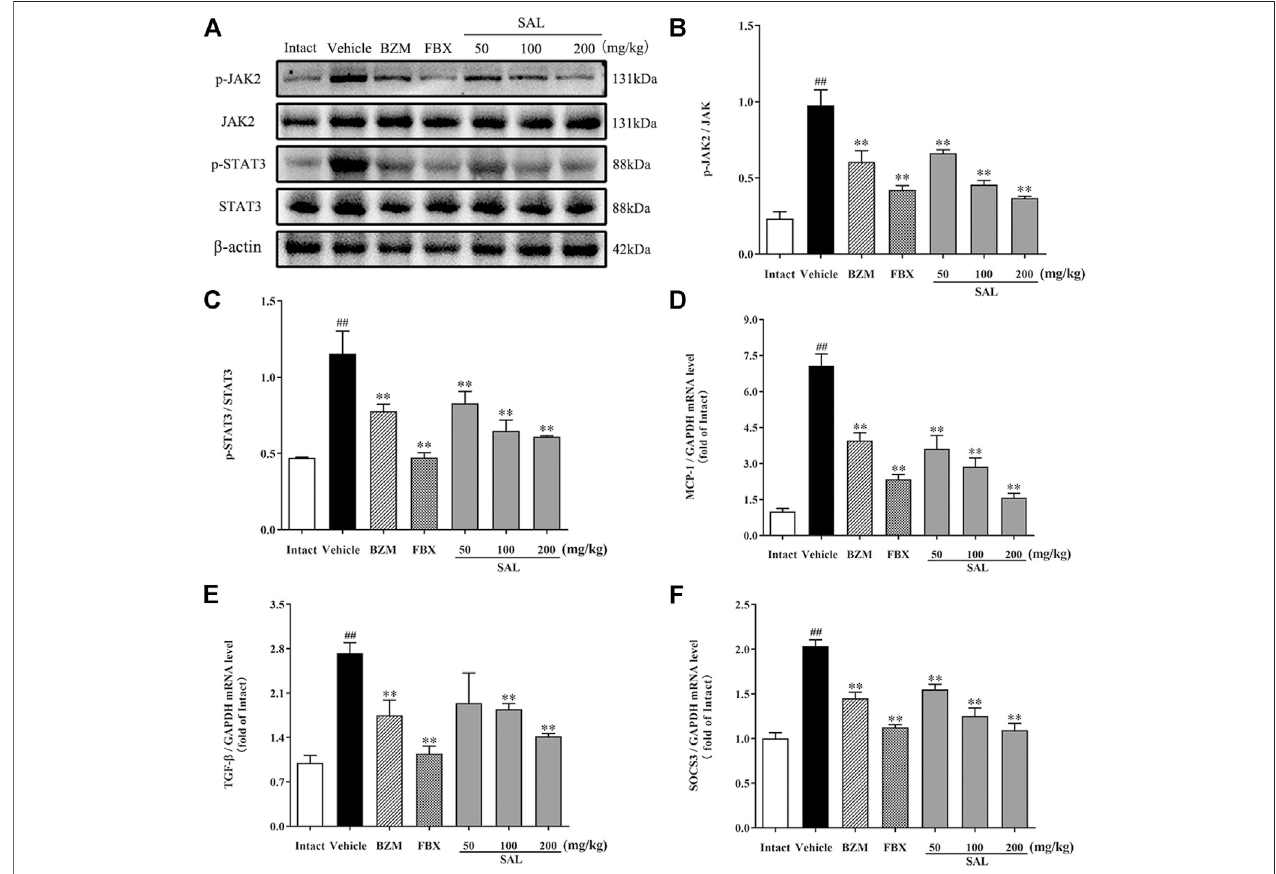
FIGURE8 | Effects ofSAL on the JAK/STAT signal pathway. (A) Theexpression levels ofthe JAK2, p-JAK2, STAT3, and p-STAT3;quantitative results ofWestern blot analyses for (B) p-JAK2/JAK2; (C) p-STAT3/STAT3; relativemRNA expression of (D) MCP-1; (E) TGF- β ; and (F) SOCS3. β -actin was used as a loading control. All data are expressed as mean ± SD ( n (cid:2) 3). ## p < 0.01 vs. the intact group, **p < 0.01 vs. the vehicle group.